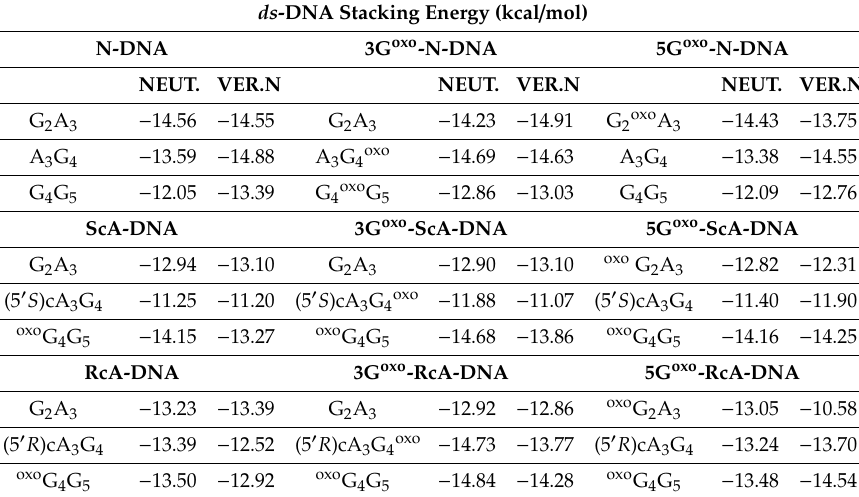
Table 4. Stacking energy interaction in kcal / mol within base pairs dimers of the discussed ds -oligonucleotides in their neutral (Neut.) and vertical neutral (after electron adoption by adiabatic radical cation) (VER.N) form geometries.